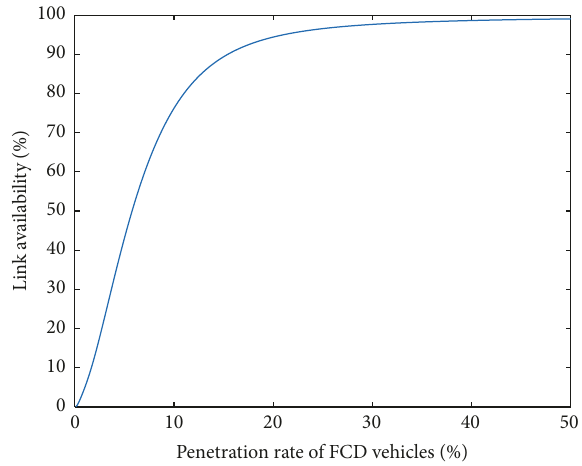
Figure 8: Estimation of the link availability for different penetration rates of FCD vehicles on the study network of the region of